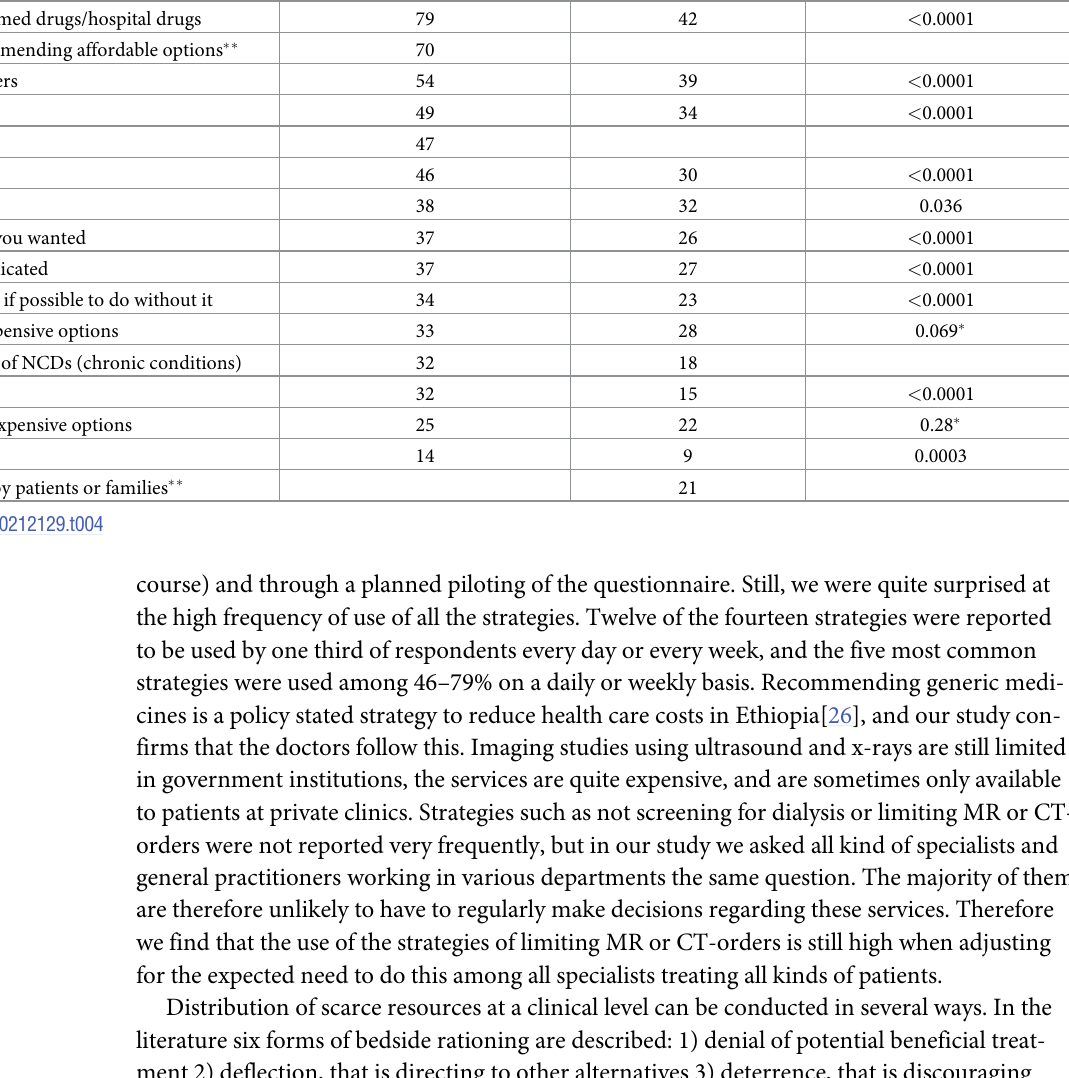
Table 4. Comparison of the strategies used daily or weekly by the physicians to save costs for the patient and family and the institution they work in. � not significant p-value �� Strategies asked only for either saving costs for the patient and family or for the institution. Strategies used daily or weekly to save costs For the patient or family.